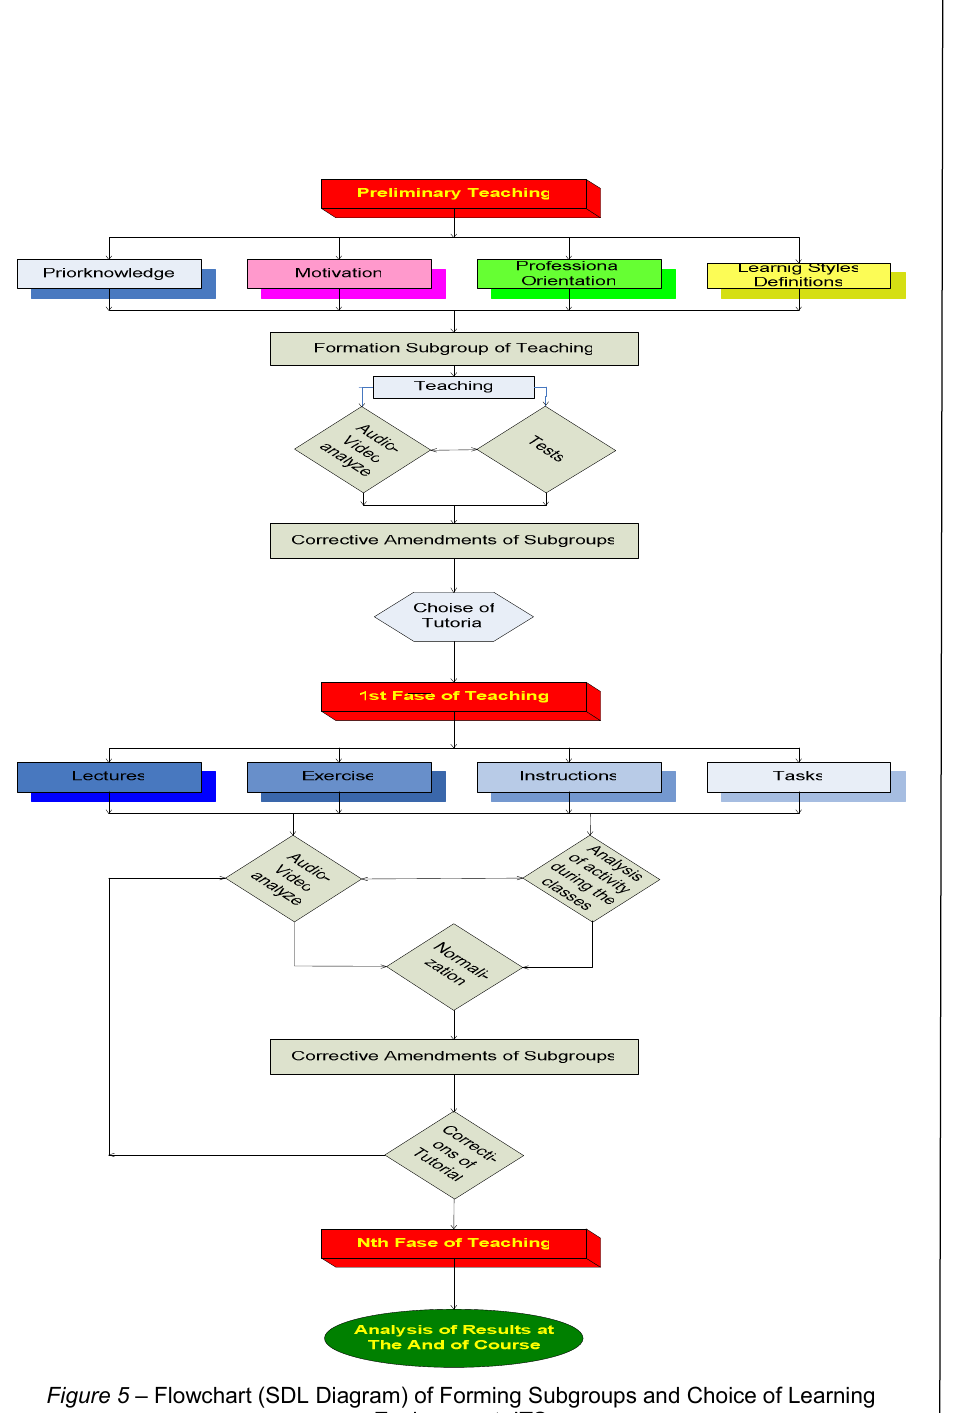
Figure 5 – Flowchart (SDL Diagram) of Forming Subgroups and Choice of Learning Environment, ITS Рис . 5 – Процесс формирования подгруппы и выбор условий обучения , ITS Slika 5 – Tok procesa formiranja podgrupa i izbira okruženja u č enja,